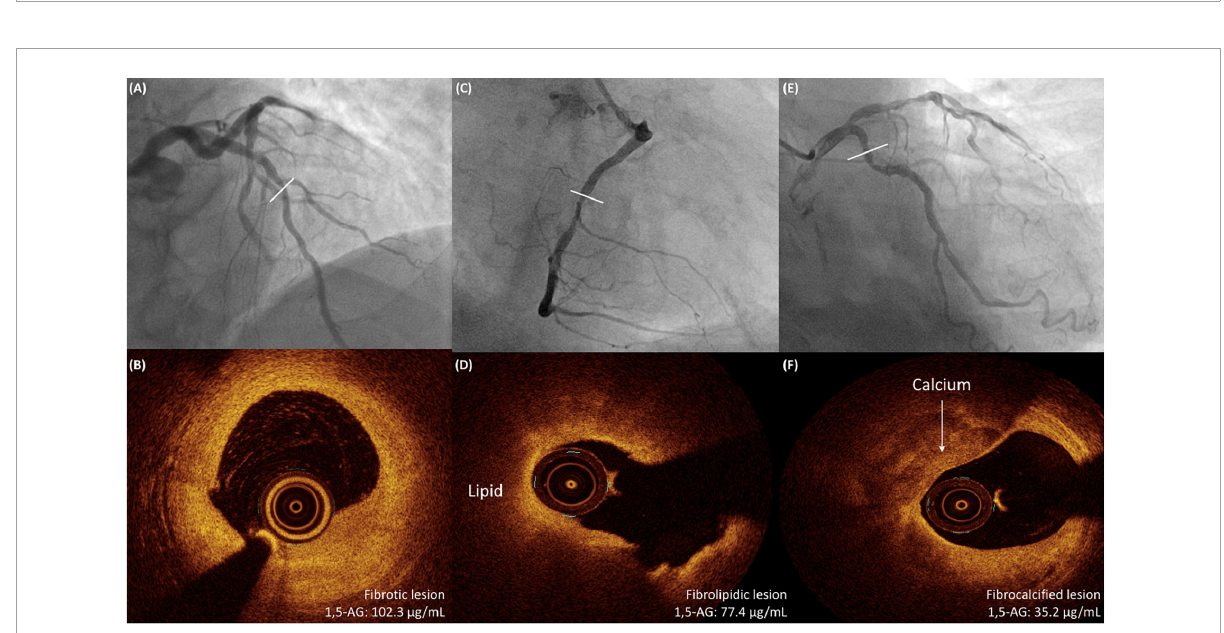
FIGURE4 Three representative cases with different correlations between OCT-detected plaque type and serum 1,5-AG levels. (A,B) A 68-year-old man with hypertension and stable angina is shown to have a lesion in the middle LAD on angiography. OCT examination shows a fibrotic lesion. The serum 1,5-AG level is 102.3 µ g/mL. (C,D) A 72-year-old man with DM and NSTEMI is shown to have a severe lesion in the middle RCA on angiography. OCT examination shows a fibrolipidic lesion. The serum 1,5-AG level is 77.4 µ g/mL. (E,F) A 68-year-old man with DM and stable angina is shown to have a diffuse lesion in the proximal LCX on angiography. OCT examination shows a fibrocalcified lesion. The serum 1,5-AG level is 35.2 µ g/mL. 1,5-AG, 1,5-anhydro-D-glucitol; DM, diabetes mellitus; LAD, left anterior descending artery; LCX, left circumflex